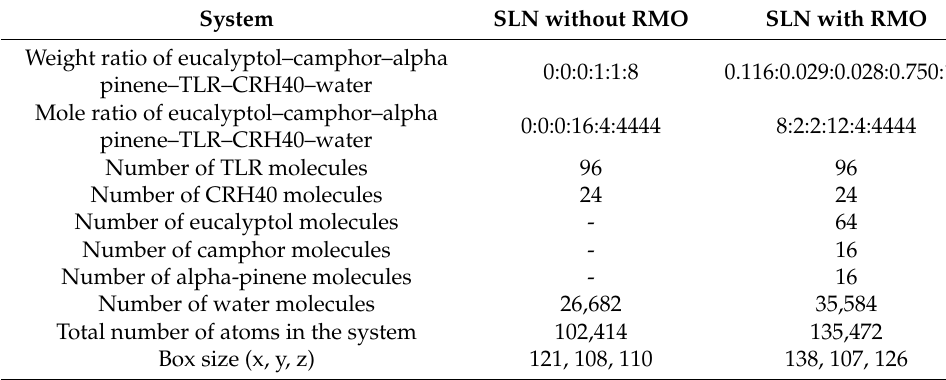
Table 1. Details of all the models used in the simulation